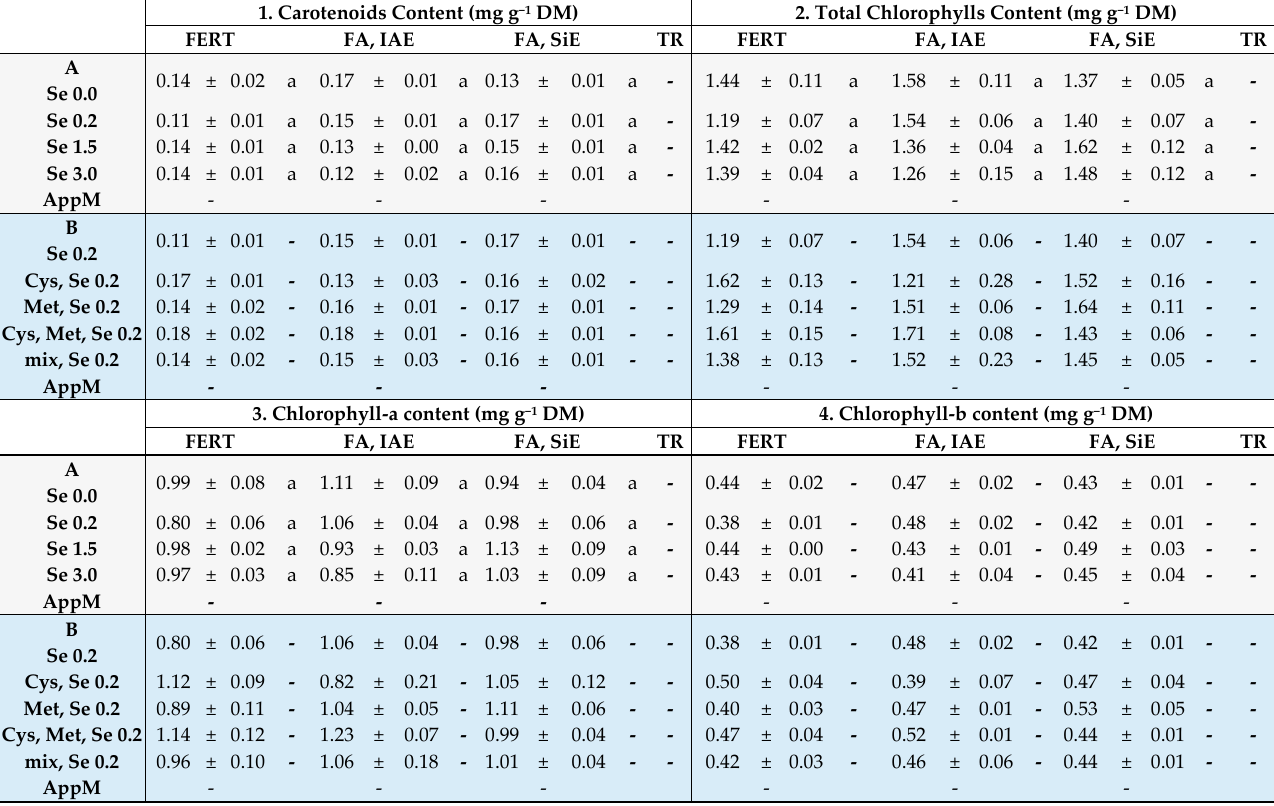
the Σ GSL content by 17% and 30%, respectively (Table 3 (2.A), Table 4). Table 2. The performance of the increased selenium concentration (A) or the combination of selenium 0.2 mM with amino acids (B) and application mode on the biofortification of florets. Means +/ − SE are provided for (1) carotenoids, (2) total chlorophylls, (3) chlorophyll-a, and (4) chlorophyll-b contents. Different letters indicate statistically significant differences in Tukey–Kramer test at p ≤ 0.05. TR : statistical evaluation among treatments. AppM : statistical evaluation among application modes. Dash indicates that the two-way ANOVA did not reveal any differences at the p < 0.05 level. In the A group, control treatment served the fertigation without Se application (Se0.0/FERT). In the B group, control treatment served the fertigation with Se 0.2 mM (Se0.2/FERT).